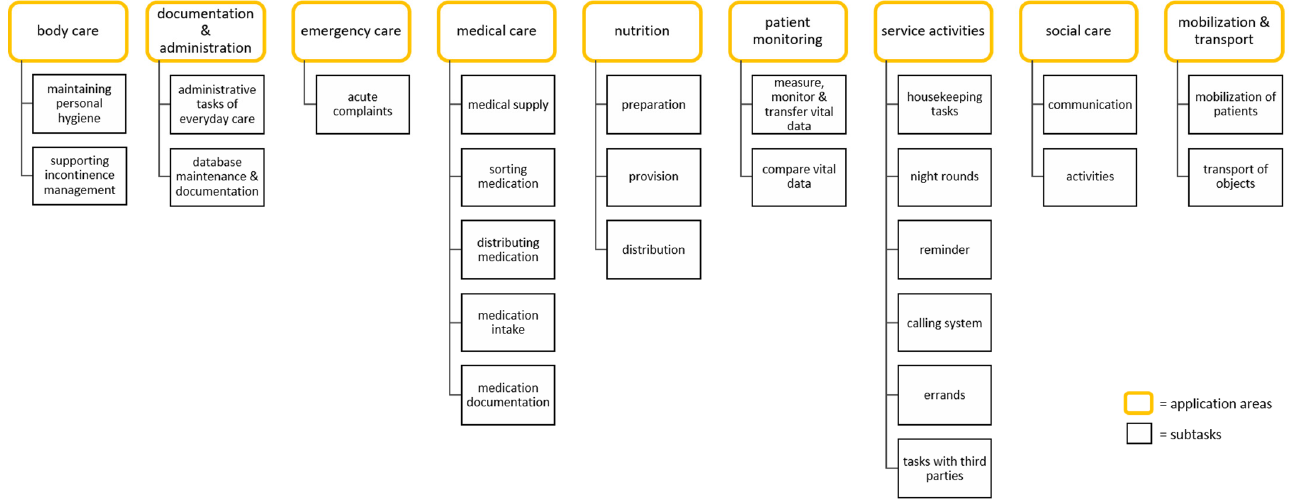
Figure 4. Identified application areas with their associated subtasks.